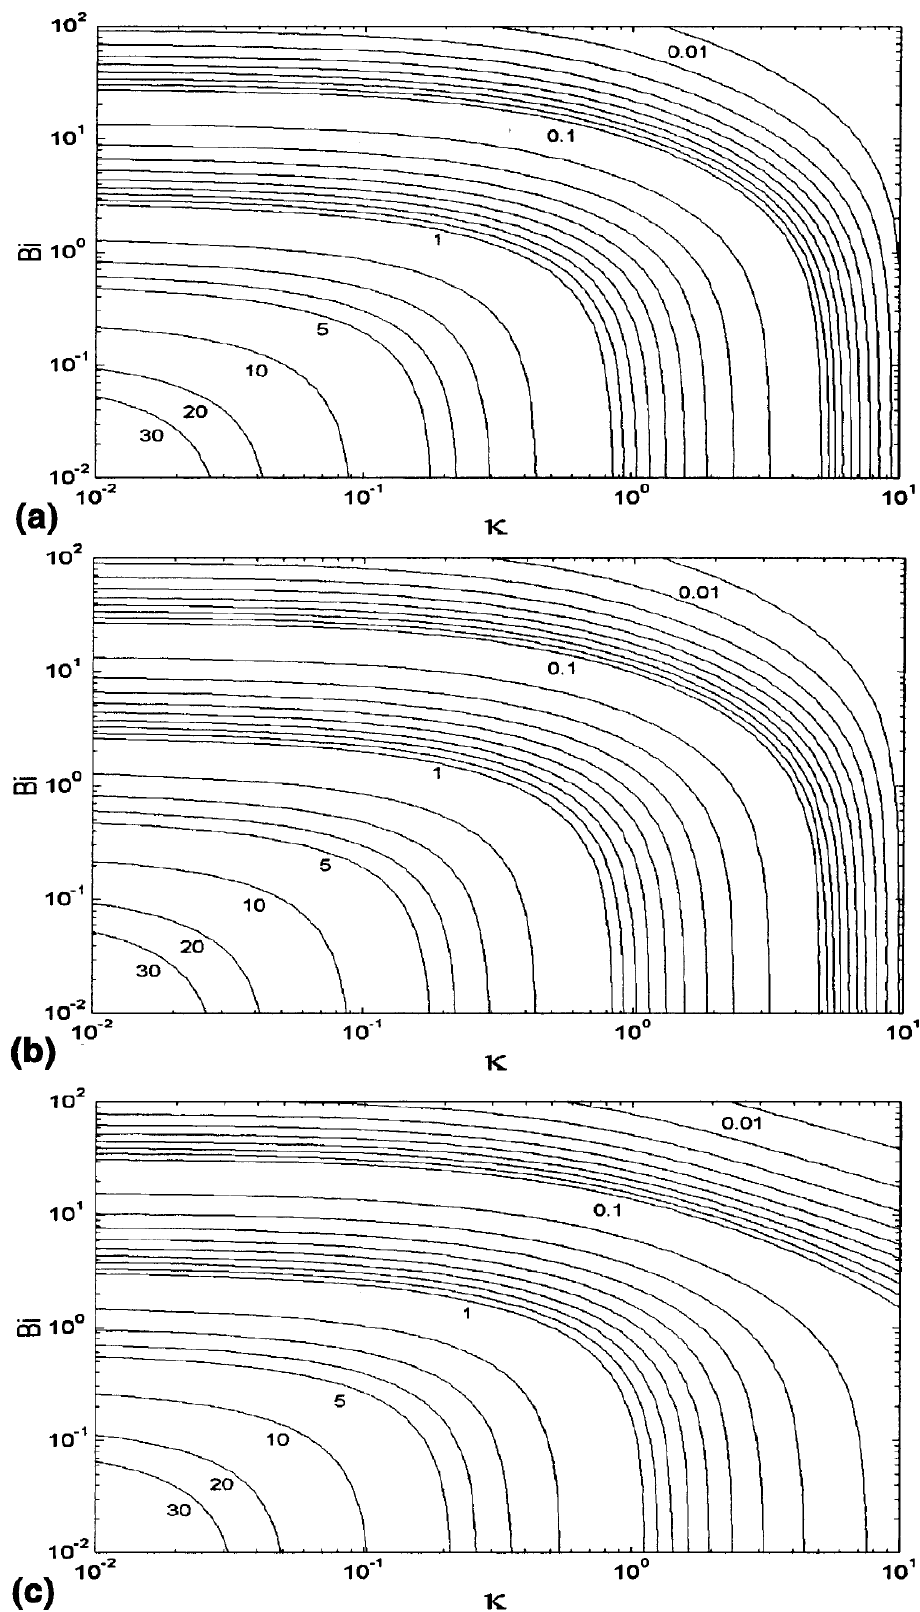
Figure 13. Error map of Nusselt number as a function of fluid/solid thermal conductivity ratio ( k ) and Biot number (Bi) for ( a ) Λ = 0, ( b ) Λ = 10, ( c ) Λ = 100, reported by Marafie and Vafai